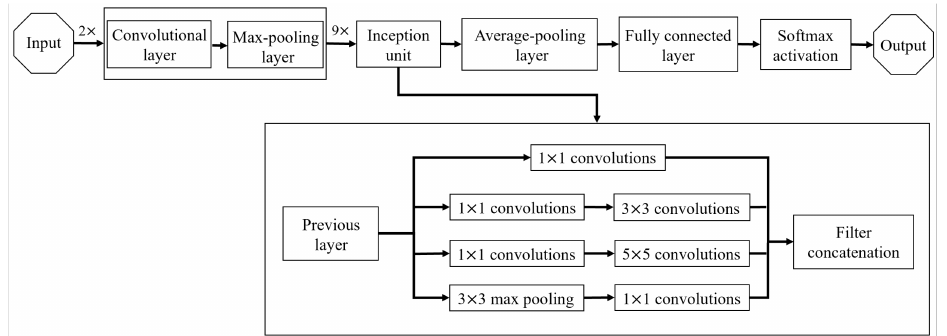
Figure 5. Simplified illustration of the GoogLeNet